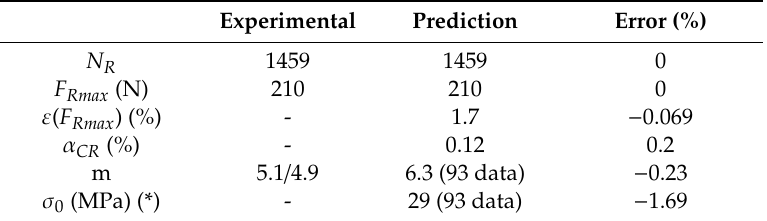
Table 2. Main characteristics of residual tensile behaviour after static fatigue (test#4 in [15]).